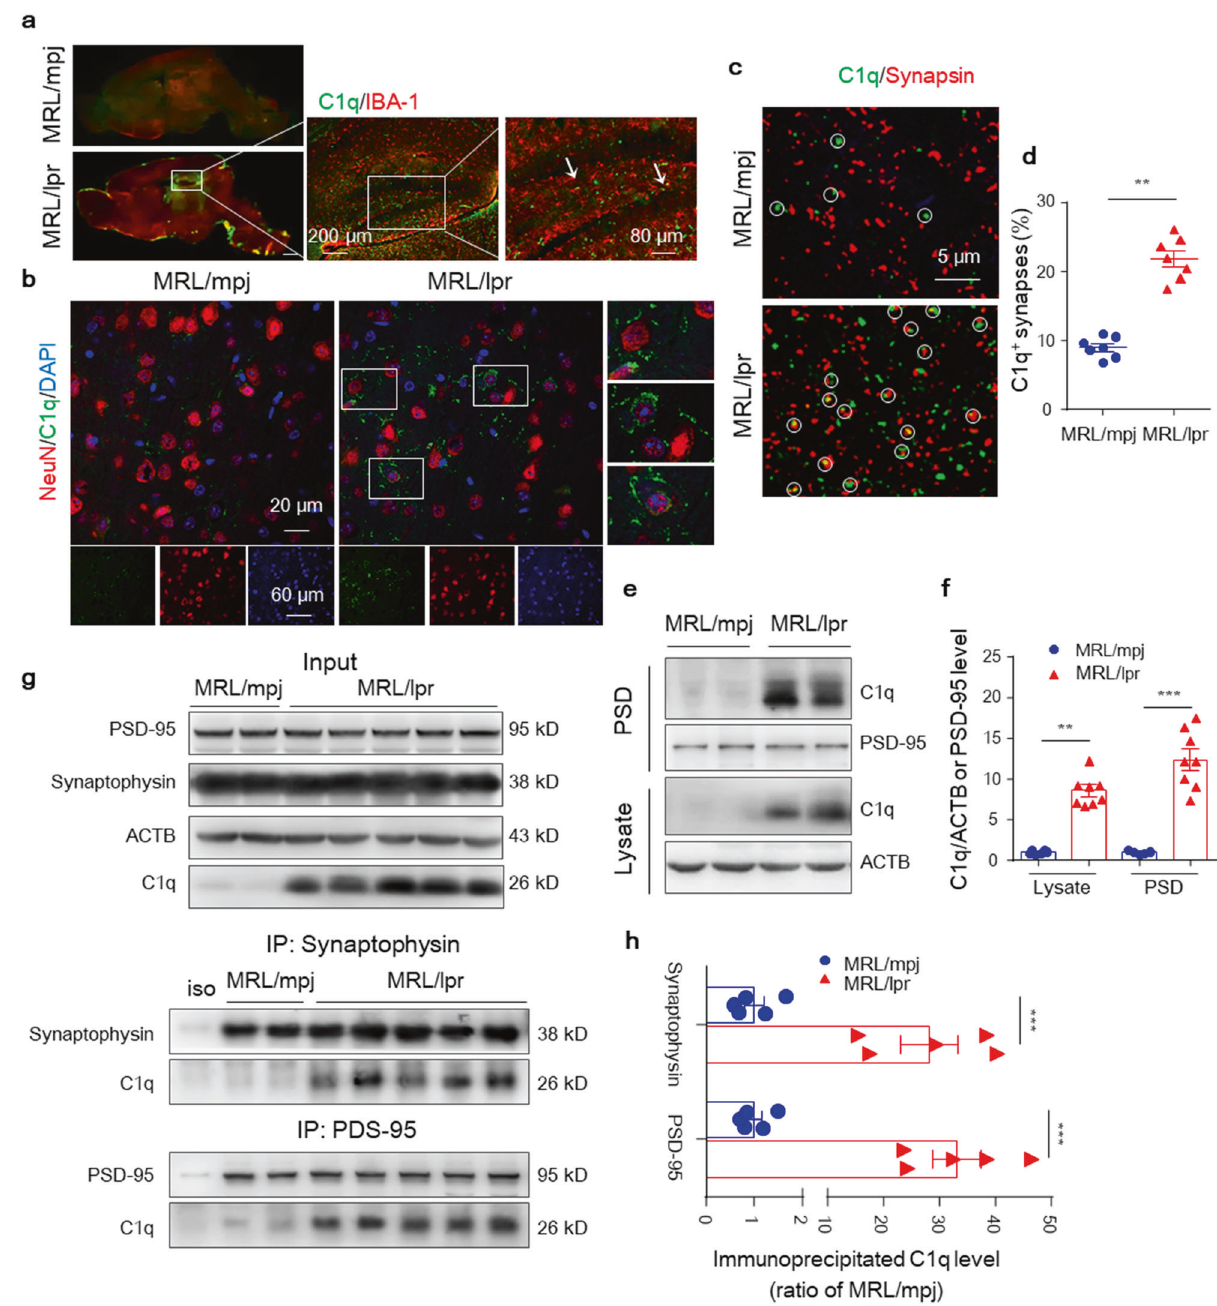
Fig. 4 Increased C1q accumulates at synapses in the MRL/lpr hippocampus. a and b Representative images of C1q stained with IBA-1/NeuN in the dentate gyrus (DG) and CA3 (mossy fi ber terminals) region of 6-week-old MRL/mpj and MRL/lpr mice. Scale bars as indicated. c and d Representative STED stacks and quanti fi cation of C1q (green) stained with synapsin (red) puncta in the CA3 region of MRL/mpj and MRL/lpr mice. Colocalized synapsin and C1q puncta are indicated by circles. Scale bar, 5 μ m. d Graph showing the percentages of total synapsin clusters colocalized with C1q. At least 120 synapses per mouse were analyzed. n = 7 mice per group. e and f Representative immunoblots and quantitation of C1q in PSD fractions and total lysates of hippocampus from MRL/mpj and MRL/lpr mice. g and h Coimmunoprecipitation analysis of C1q with synaptophysin or PSD-95 antibodies in MRL/mpj or MRL/lpr hippocampal lysates. The data are the mean ± SEM. ** P < 0.01 and *** P < 0.001 according to a two-tailed Student ’ s t -test in ( d ) and one-way ANOVA with Tukey ’ s post hoc test in ( f , h ). See also Supplementary Fig. 6